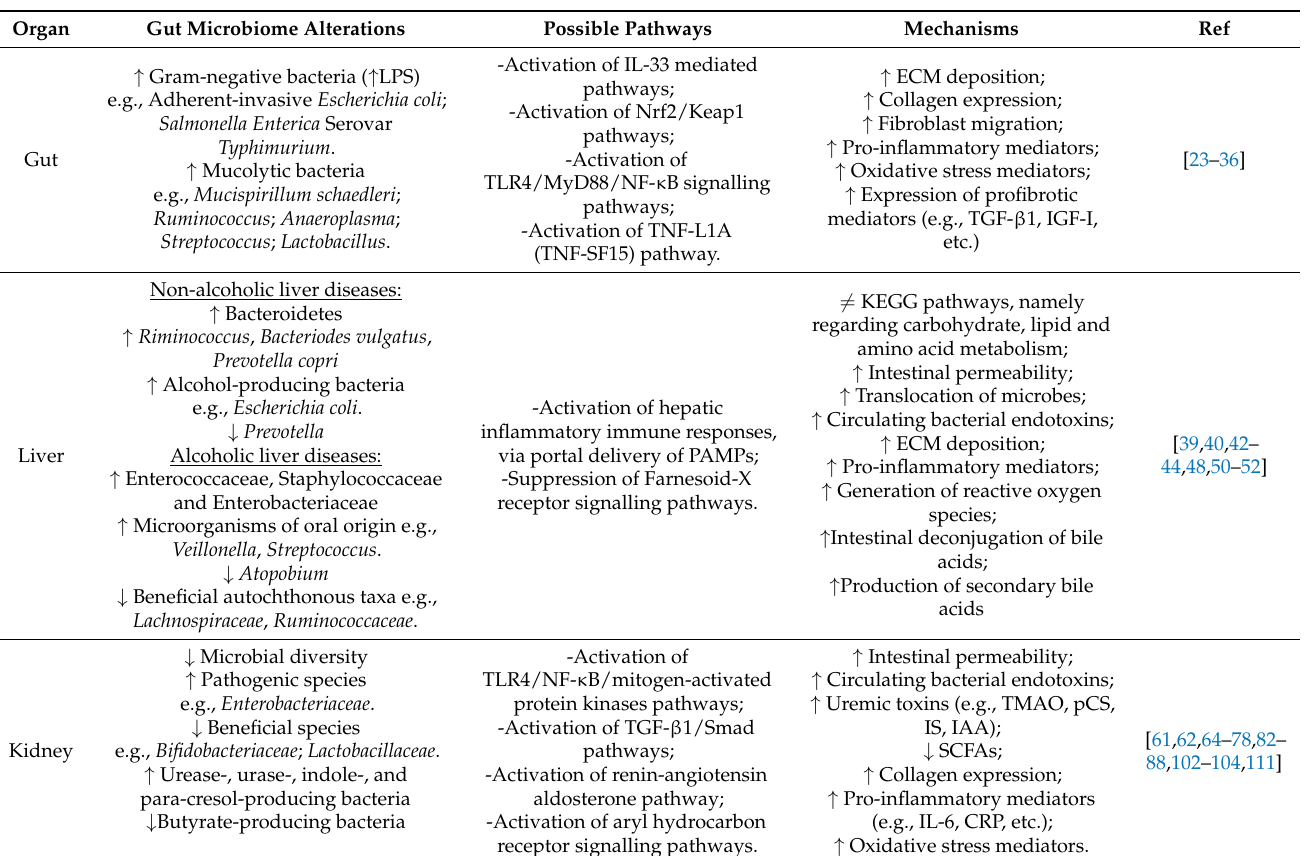
Table 1. Alterations of gut microbiota associated with organ